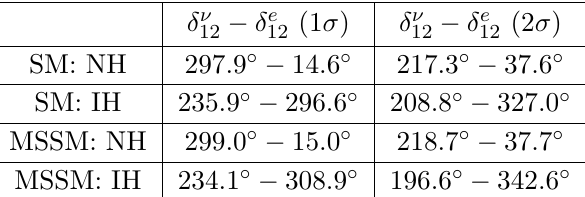
Table 4 . Viable 1 σ and 2 σ HPD intervals for δ ν of neutrino observables. RG evolution for the SM and the MSSM are considered for both NH and IH, as discussed in the main text. We note that in all cases the 2 σ intervals contain 270 ◦ = − π